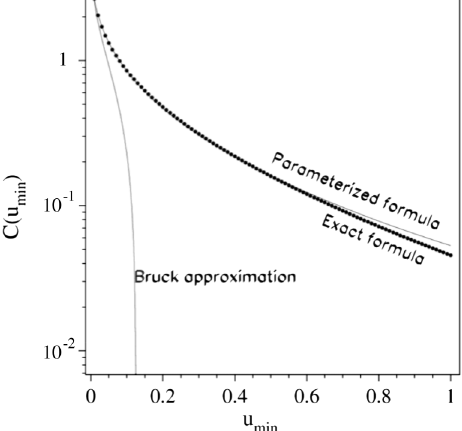
FIG. 1. Comparison between exact formula of C ð u min Þ as in formula (5) and its parametrization. The numerical fit starts to diverge from the exact formula only at u min values larger than 0.7 Approximation can be used only for small u min